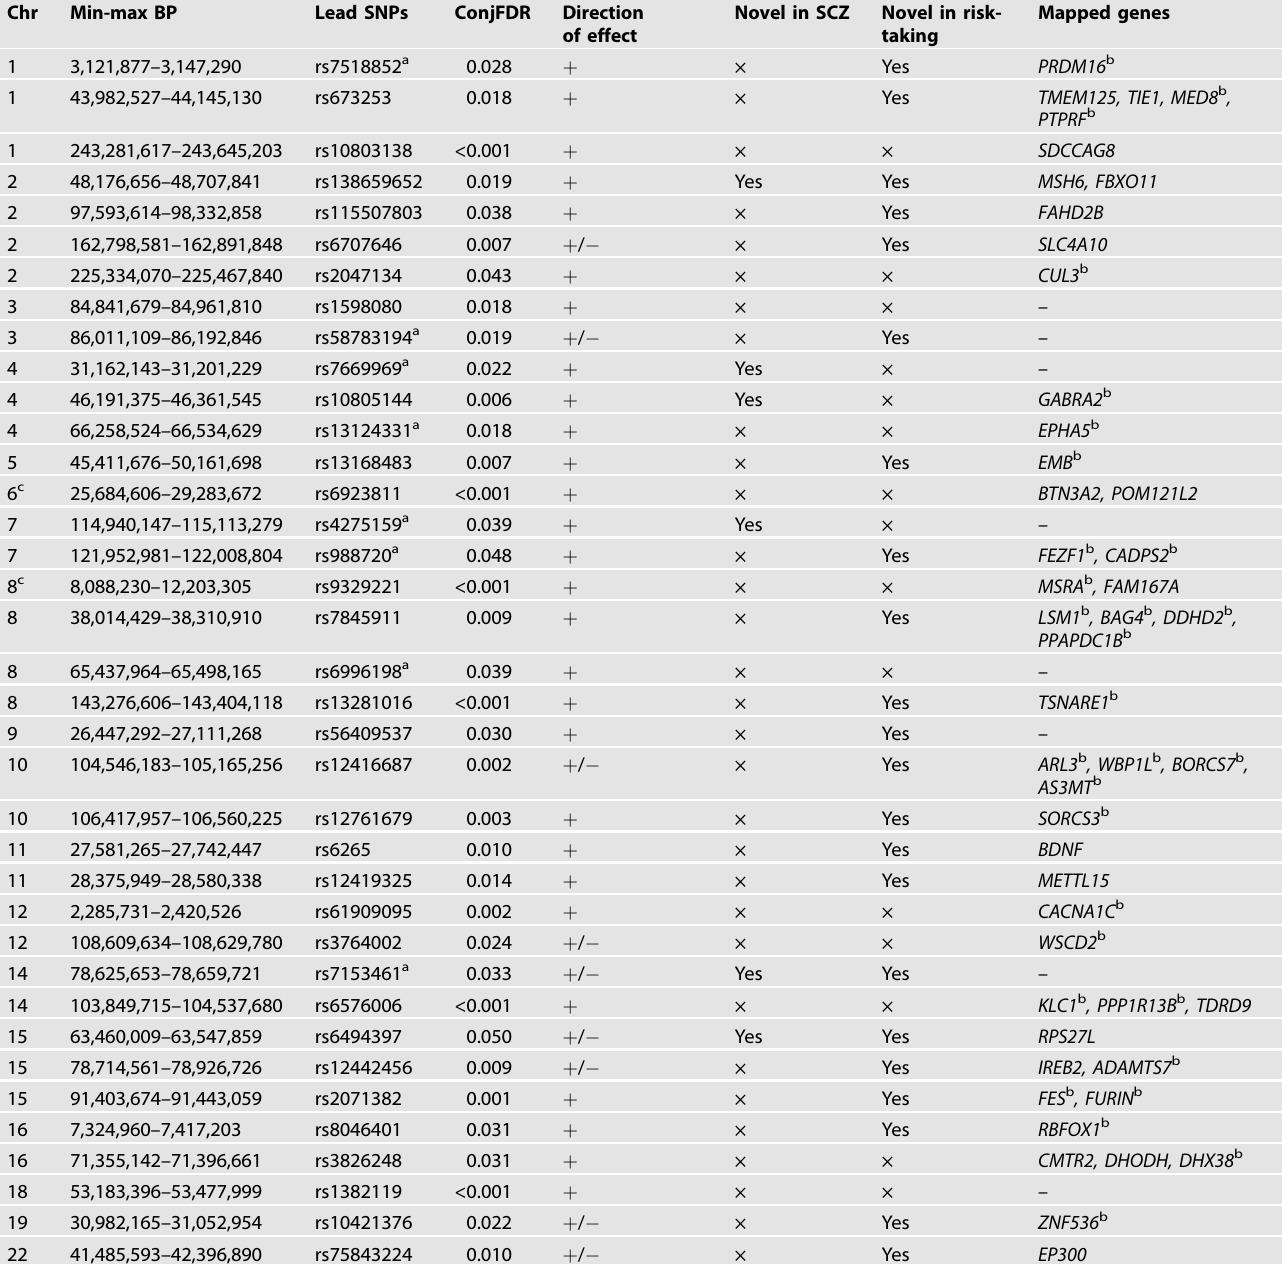
Table 2. Thirty-seven genomic loci jointly associated with schizophrenia (SCZ) and risk-taking which physical overlapped with loci jointly associated with SCZ and risky behaviours at conjunctional FDR (conjFDR) <